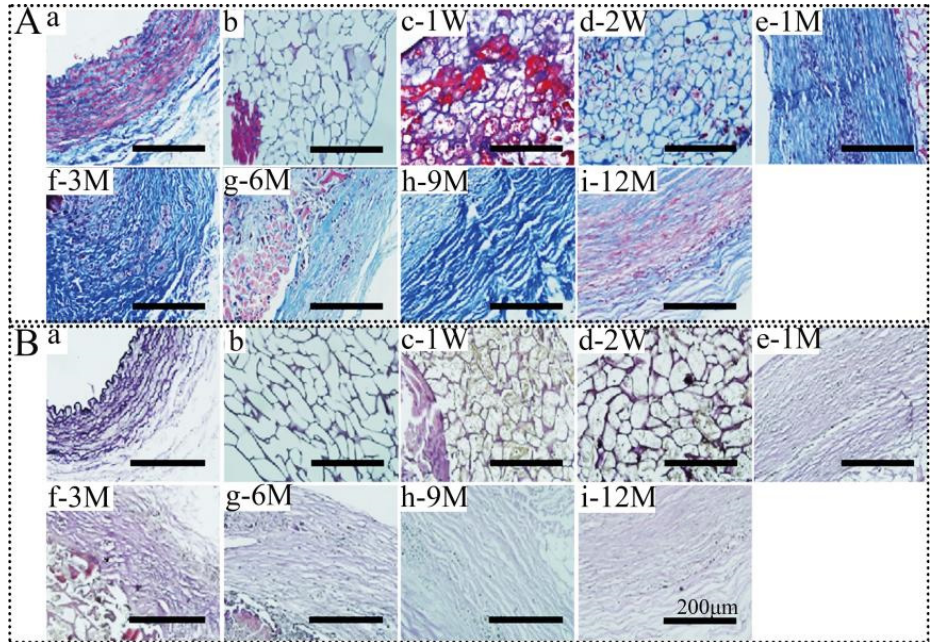
Figure 7. Masson ( A ) and WVG staining ( B ) of SFTSs after implantation. ( a ) Autogenous carotid artery; ( b ) non-implanted SFTS; ( c – i ) represent the different time points after implantation. The scale bar is 200 μ m.